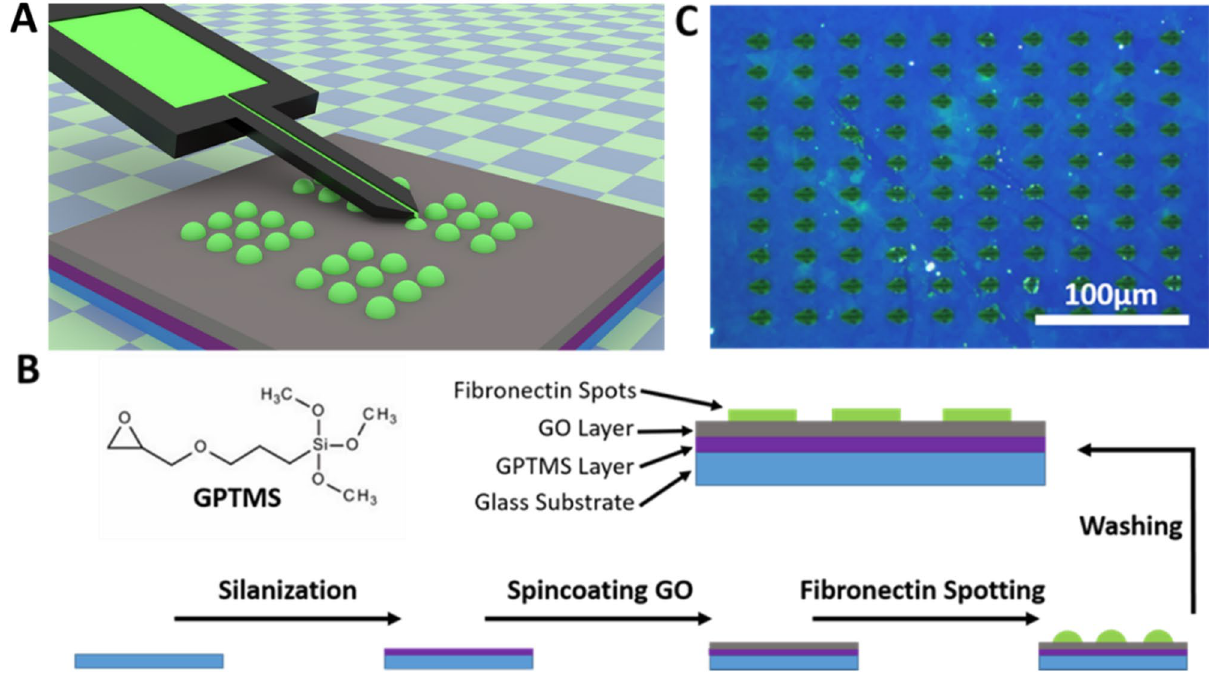
Figure 1. Preparation of protein arrays on graphene oxide substrates. ( A ) Scheme of microchannel cantilever spotting (µCS) technique, used for spotting fibronectin onto graphene oxide substrates. ( B ) Steps in the preparation of the protein arrays: a clean glass substrate is silanized with GPTMS. Next, Graphene oxide (GO) flakes are deposited by spin coating and fibronectin containing ink is spotted by µCS. After washing away excess ink, fibronectin spots remain on the substrate. ( C ) Fibronectin ink droplet microarray under polarized light after spotting